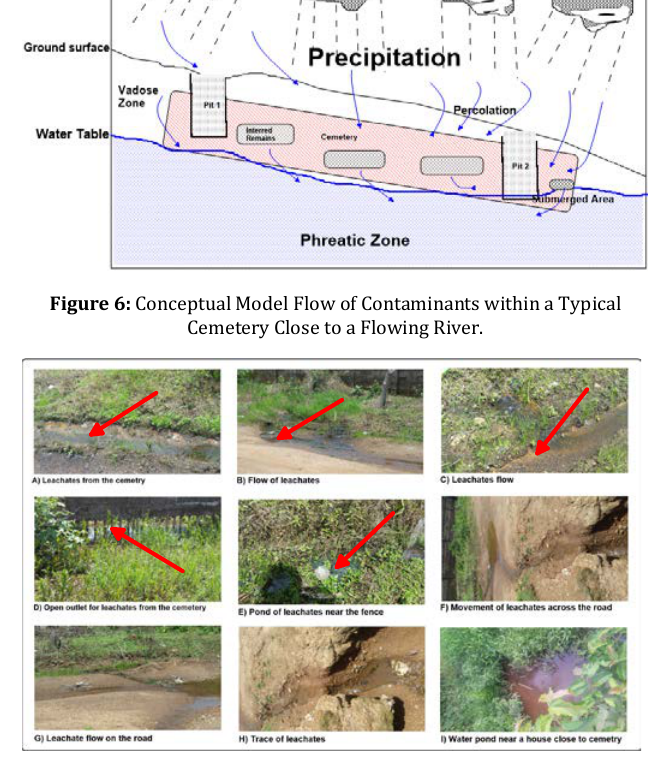
Figure 7: Field Pictures of Flow of Leachate from Cemetery to A Body of Water.